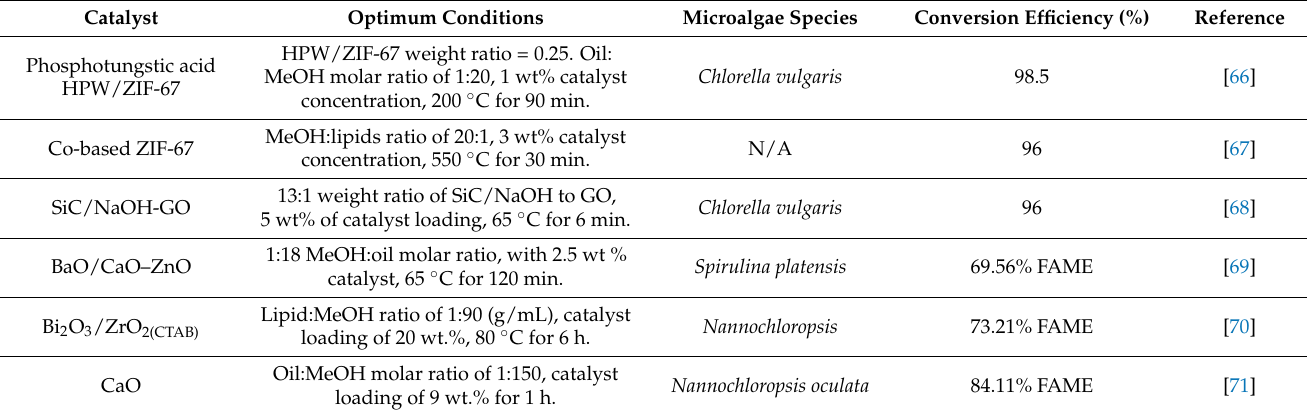
Table 2. Basic and acidic catalysts used for biodiesel production from